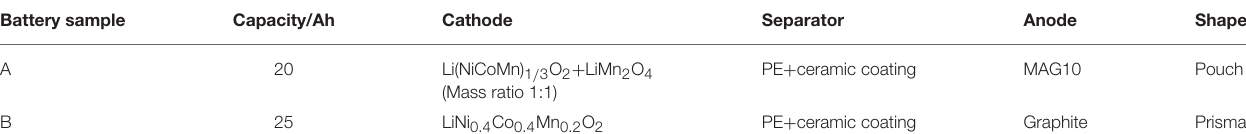
TABLE 1 | The battery samples used in the calorimetric tests.